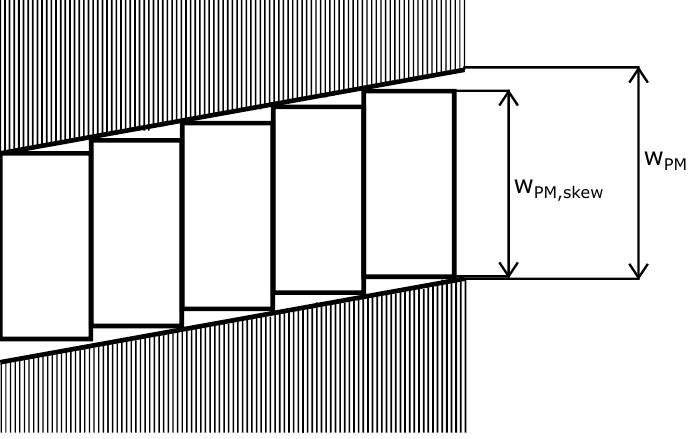
Figure 16. Permanent magnet step-skewing.